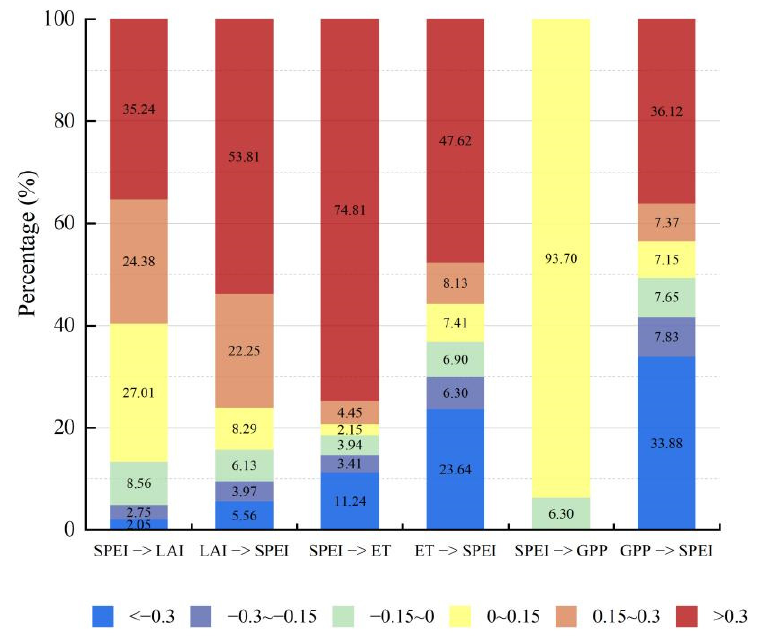
Figure 9. The proportion of pixels of cumulative pulse coefficient among SPEI and ecosystem functional indicators.